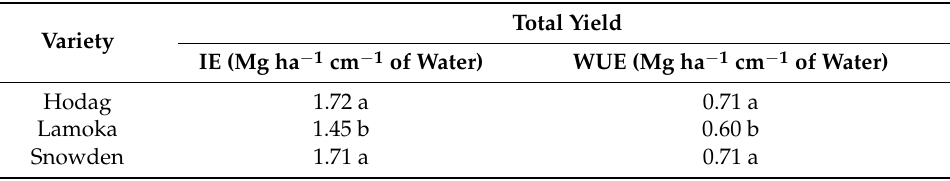
Table 6. Varietal difference of irrigation efficiency (IE) and water-use efficiency (WUE) for producing total yield of the three chipping varieties in 2019. Within each column, numbers followed by different letters are significantly different at α =